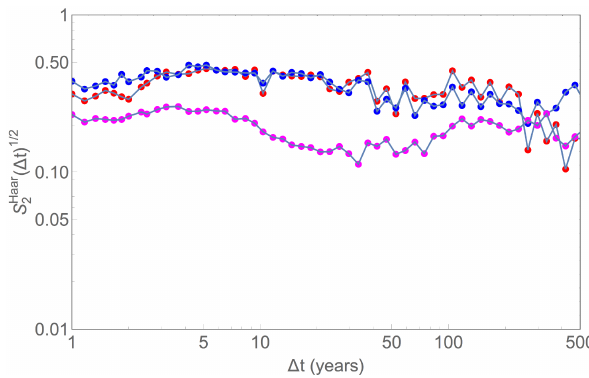
Figure 4. Haar fluctuations for NorESM data. Red curve: Haar fluc- tuation of the response to solar + volcanic forcing. Blue curve: the Haar fluctuation of the summed solar and volcanic response. Ma- genta curve: Haar fluctuation of the control